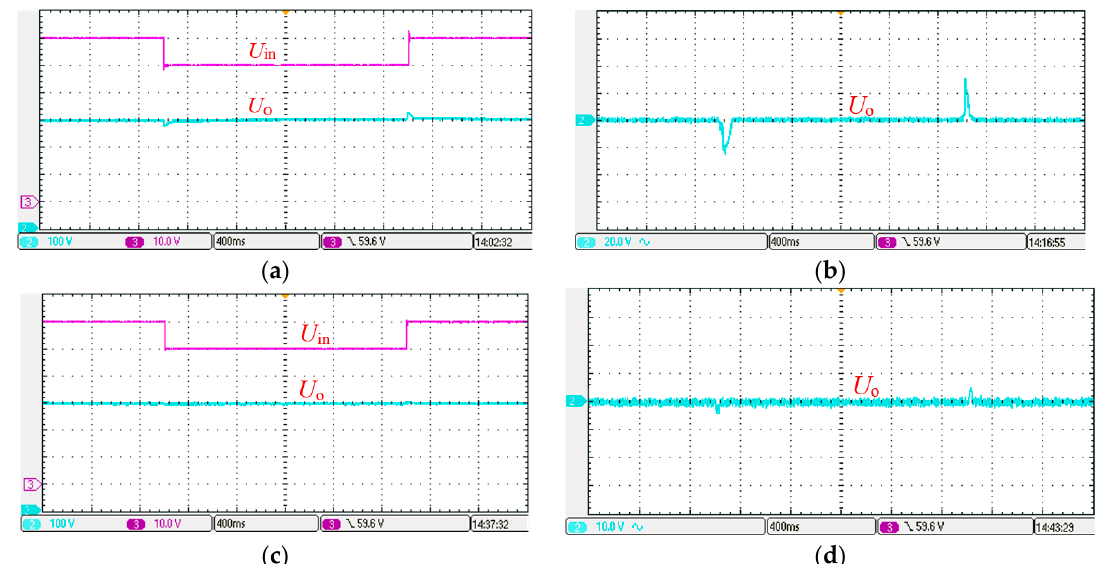
Figure 16. The output voltage waveform during input voltage disturbance. ( a ) Without feedforward compensation (DC coupling measurement); ( b ) without feedforward compensation (AC coupling measurement); ( c ) with feedforward compensation (DC coupling measurement); ( d ) with feedforward compensation (AC coupling measurement).